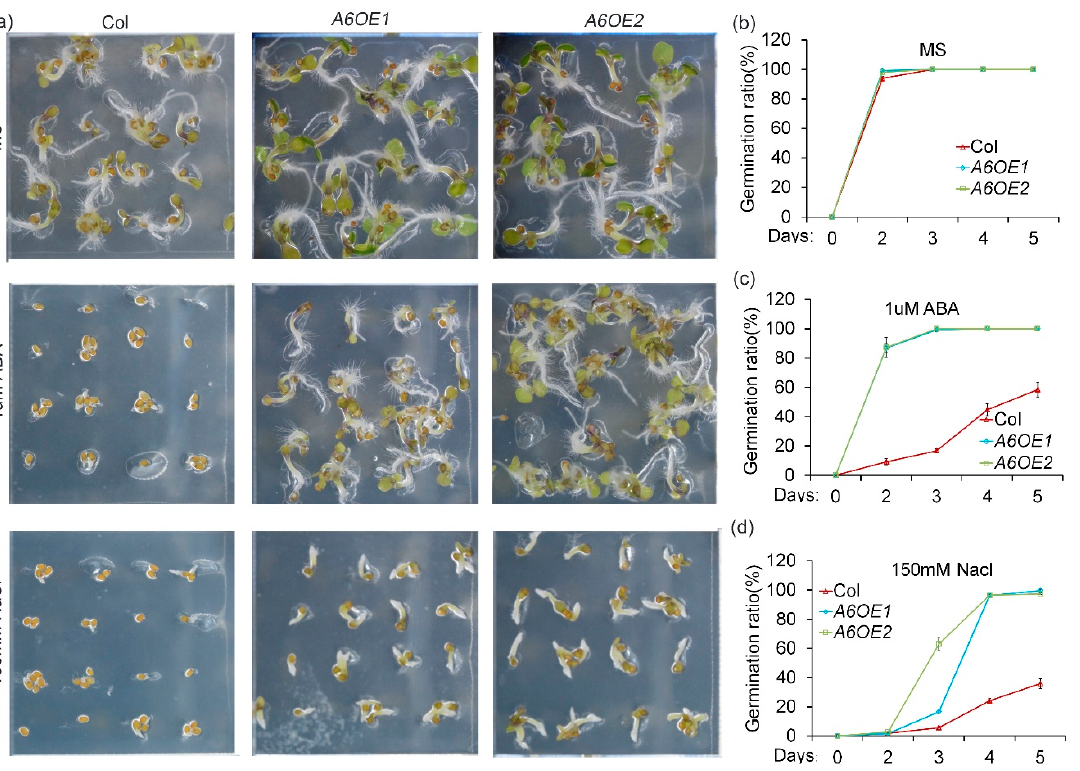
Figure 3. Overexpression of ZmPP2C-A6 in Arabidopsis increased tolerance to ABA and salt stresses. Germination phenotypes ( a ) (Bar = 0.5 cm) and statistical analyses ( b – d ) of Col and two ZmPP2C-A6 overexpressing lines ( A6OE1 and A6OE2 ) sown on MS medium ( b ) or MS medium supplemented with 1 μ M ABA ( c ) or 150 mM sodium chloride ( d ). Data represent the mean ±SD of three replicates in ( b – d ).